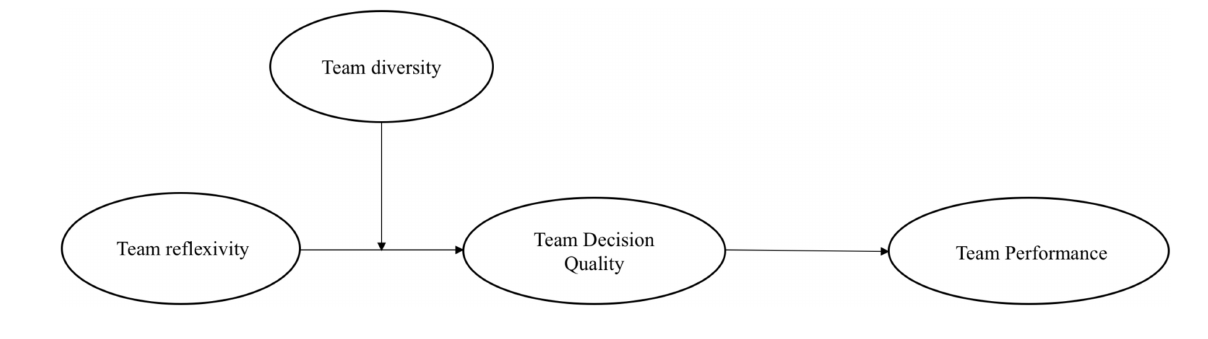
FIGURE 1 | Conceptual